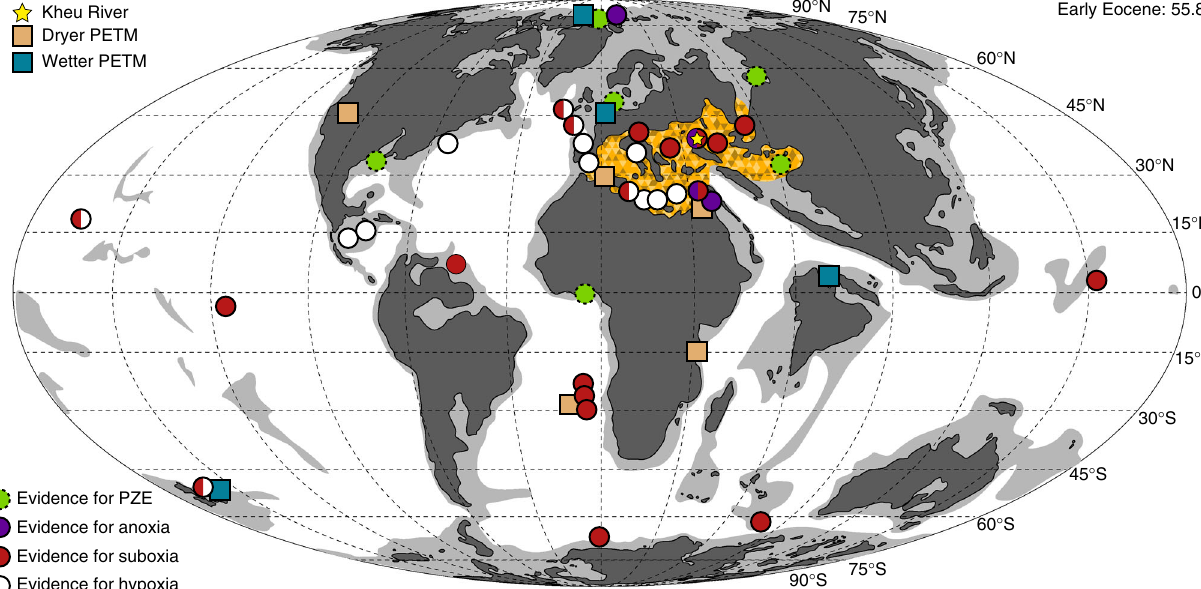
Fig. 1 Paleogeographic map of the PETM. Map adapted from plate tectonic reconstructions by Scotese 66 with relevant data on redox and hydrologic indicators at PETM sites. Deoxygenation and hydrologic data from Carmichael et al. 20 and references therein. Orange shaded region shows the extent of strata that displayed TOC enrichment from background during the PETM in the Tethys